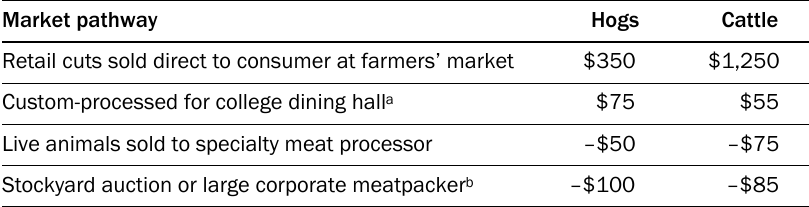
Table 3. Estimated Average Net Returns per Head (US$) for Hogs and Beef Cattle Sold in 2011–2012 Through Different Market Pathways The return values are after accounting for production, processing, transportation, marketing, storage, and sales costs (including estimates of labor inputs). The first two represent pork and beef sales as frozen meat products while the other two pathways are sales of live